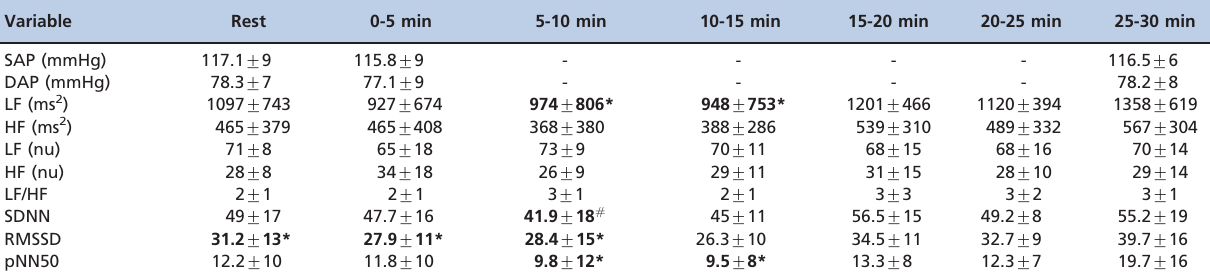
Table 2 - Diastolic and systolic arterial pressure; the time in minutes (min) and frequency domain indices before and after exposure to exercise with a flexible pole. Low frequency; high frequency; low frequency/high frequency ratio; standard deviation of the normal-to-normal R-R intervals; percentage of adjacent RR intervals with a difference in the duration greater than 50 ms; and root-mean square of differences between adjacent normal RR intervals in a time interval. Mean ¡ Standard Deviation. Milliseconds; millimeters of mercury. * p , 0.05: vs . 25-30 min. # p , 0.05: vs . 15-